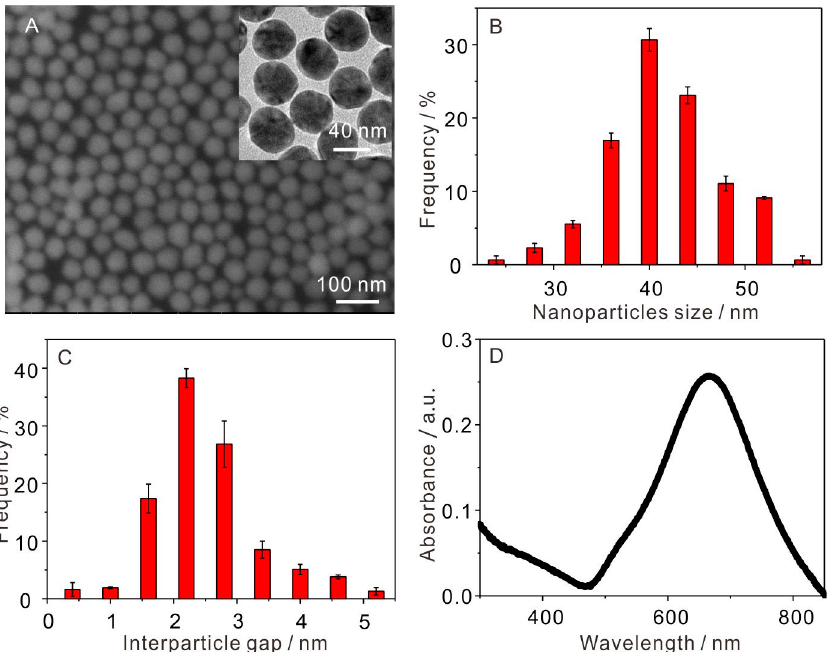
Figure 1. ( A ) SEM observations on Au nanoparticle (NP) arrays (inset in A: TEM of self-assembled Au NP arrays); ( B ) nanoparticle size distribution histograms of Au NPs arrays; ( C ) interparticle gap distribution histograms of Au NPs arrays; ( D ) absorbance spectra of self-assembled Au NPs arrays transferred onto a quartz glass surface.